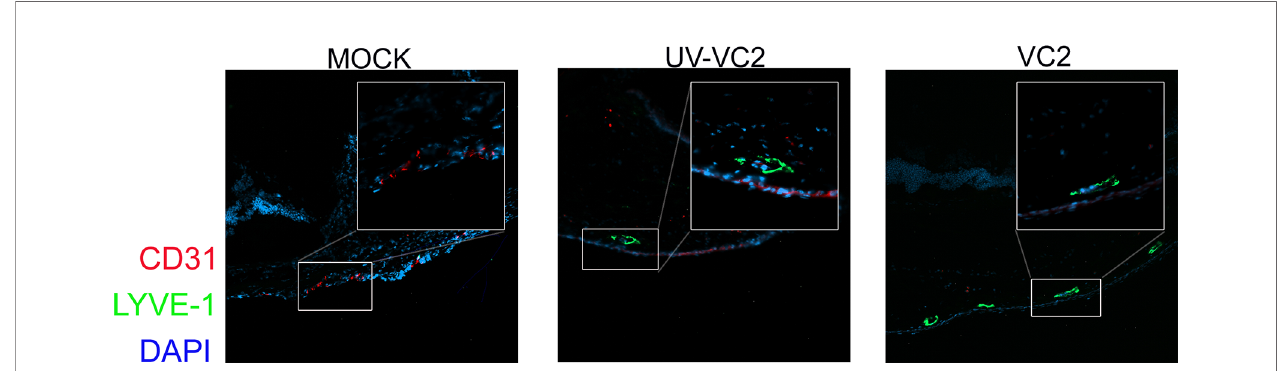
FIGURE 4 | Neovascularization and lymph-angiogenesis in ocular tissues. IFM on OCT sections was used to detect the presence of neovascularization (CD31-red) and lymph-angiogenesis (LYE-1 green).